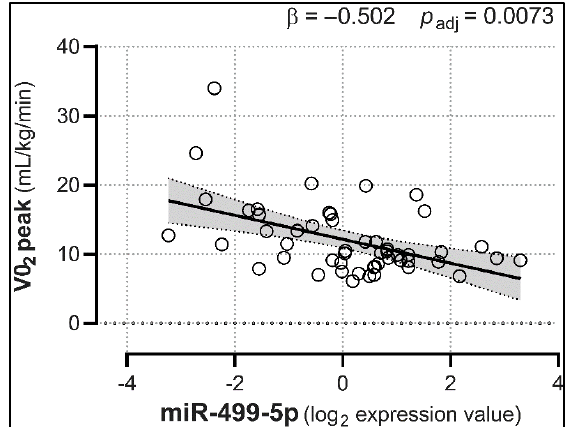
Figure 4. Expression levels of plasma miR-423-5p are associated with both NT-proBNP and LVEDV. HF-regulated miR-423-5p showed positive associations with both NT-proBNP ( A ) and LVEDV ( B ). Analyses were adjusted for age, sex, personal history of diabetes mellitus, hypertension, and/or hypercholesterolemia, and smoking habit. Trendlines are depicted along with the 95% confidence interval (light gray). p adj = p -values corrected for multiple comparisons; n = 61.